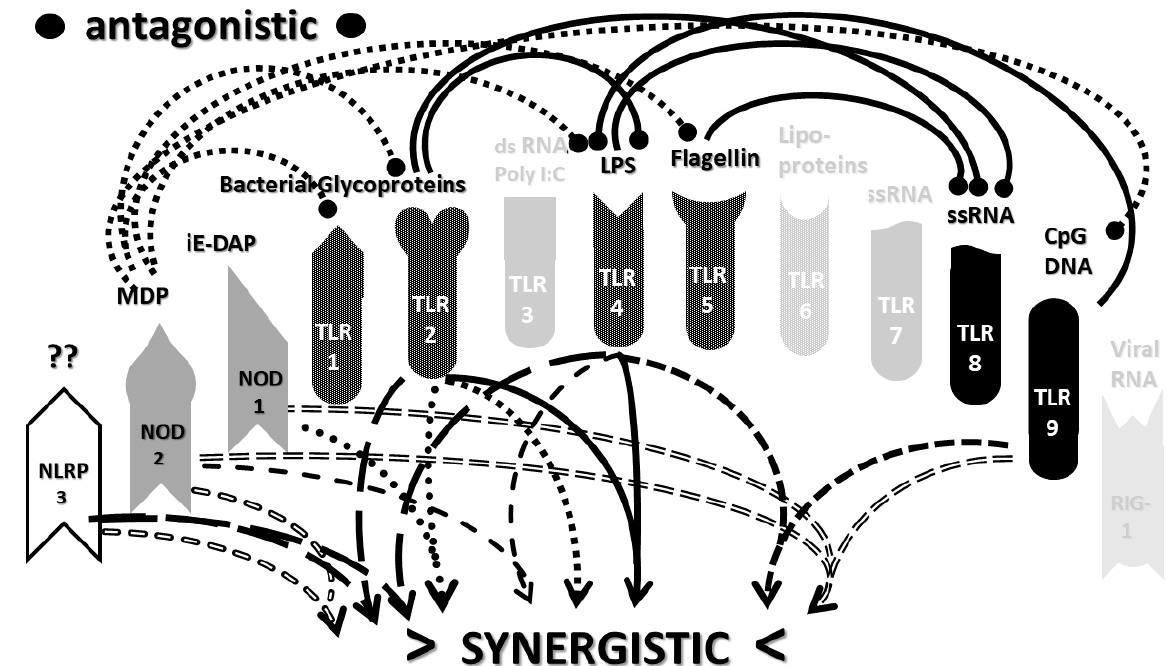
Figure 10. Activation pattern model for polymicrobial sepsis based on a combination of Gram-positive and Gram-negative bacteria from Table 2. Note the several antagonistic interactions on TLR8, which may explain why it is not activated during sepsis. TLR1 is also antagonized (in this case, by NOD2 and, probably, NOD1 as well) and has no synergisms to offset these, so it, too, does not appear to be activated during sepsis (Tables 1 and 5). For other TLR, synergisms outnumber the antagonisms, so these receptors will presumably continue to be activated with TLR8-activating PAMPs (Tables 1 and 5). A very similar pattern results from combinations of bacteria with fungi, as can be seen with reference to Tables 2 and 3. Note the distinct differences from Figures 3A and 8 (severe COVID-19) and Figures 3B and 9 (influenza-associated ALI/ARDS), illustrating the fact that cytokine storms may have distinctly different patterns of innate receptor activation.